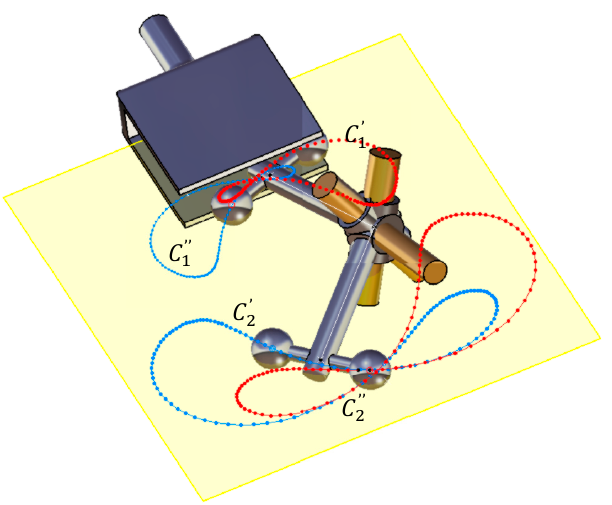
Figure 24. Kinematics simulation of the paths of the centers of the balls in the median plane of the channel for the two assembling solutions.